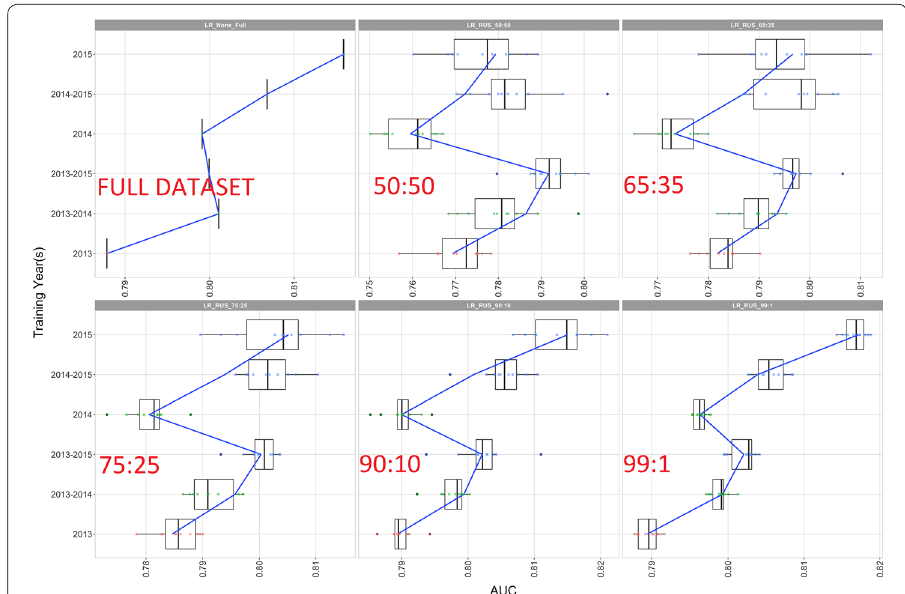
Fig. 2 Logistic Regression box plots (Part